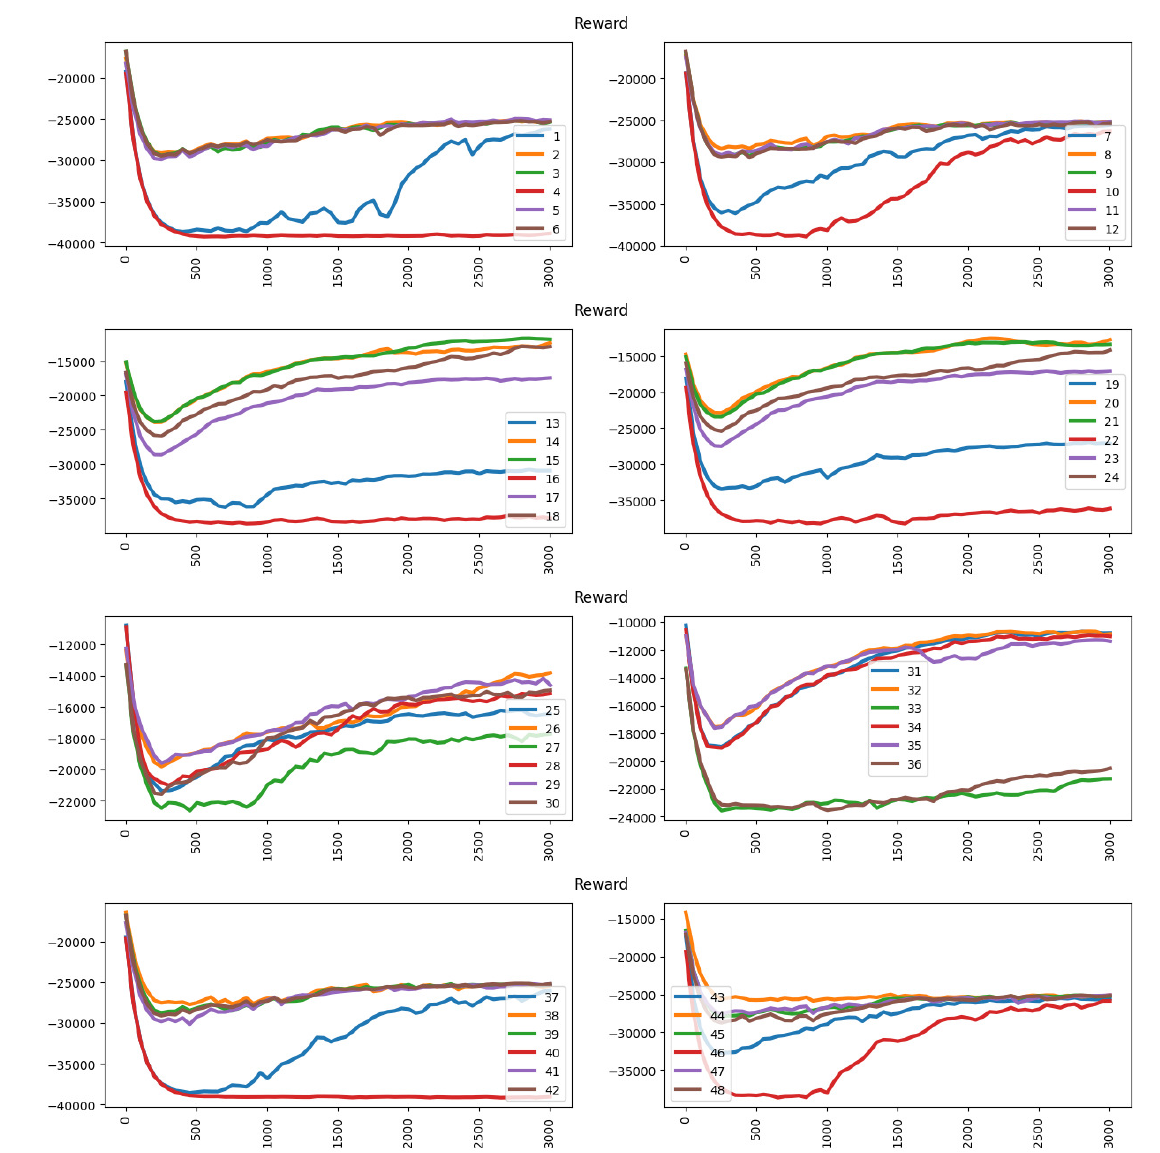
Figure 13. Reward result under vehicle the flow regulation